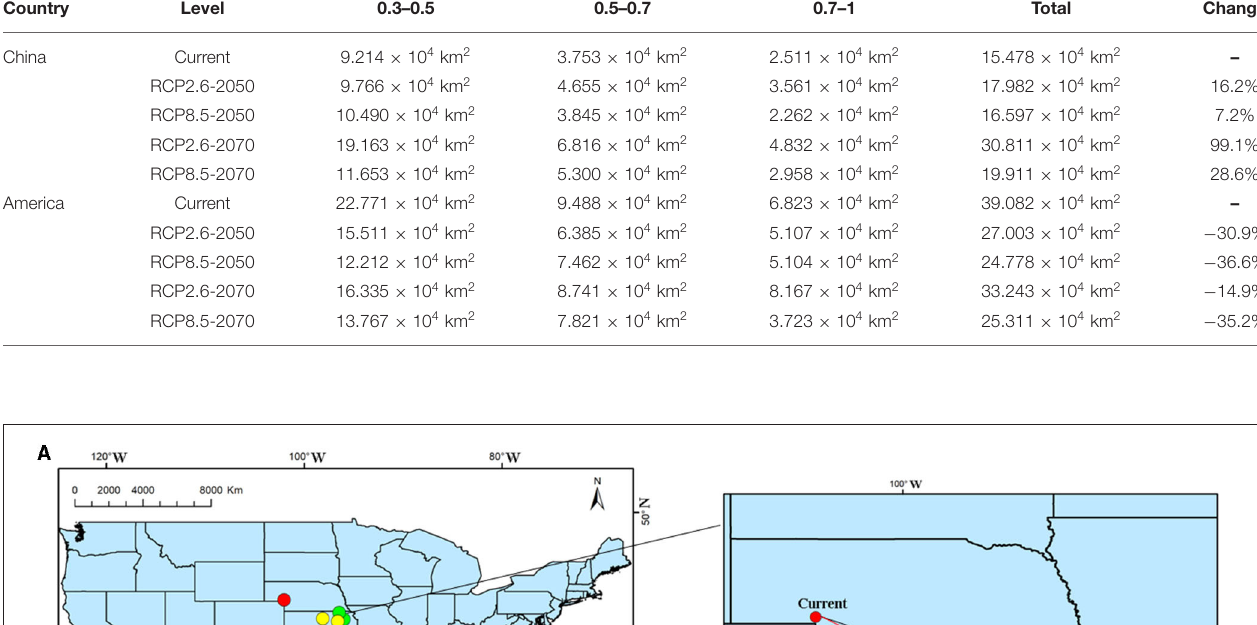
TABLE 2 | The total area in China and America with S. alterniflora ecological suitable distribution levels > 0.3 under RCP 2.6 and 8.5. Country